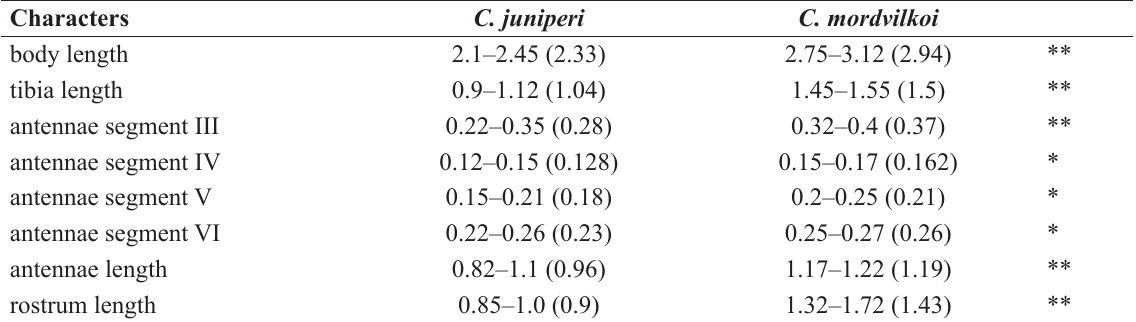
Hind tibiae pale or with a pale zone between the dark knee and apex ................................. ............................................................................. Cinara (Cupressobium) Börner, 1940 Cinara (Cupressobium) cupressi (Buckton, 1881)